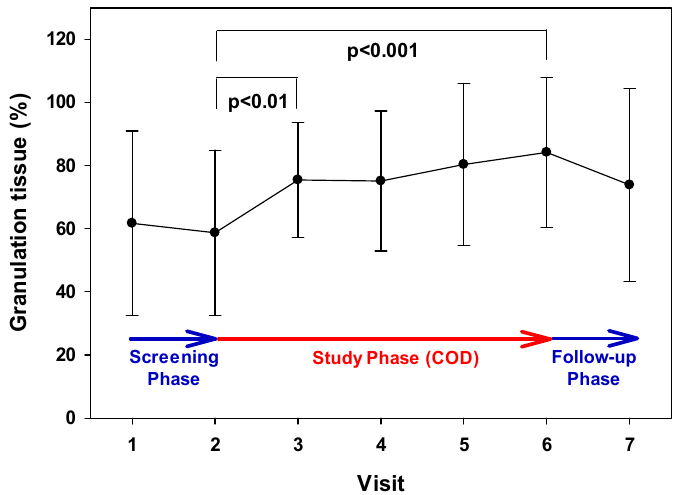
Figure 7. Increase in granulation tissue formation during the Treatment Phase. The mean and SD values of the mean of the granulation scores during each visit are presented. During the Treatment Phase (Visits 2–6), there was a statistically significant increase in the granulation tissue (43.37%; p < 0.001; one-way repeated measures ANOVA). Between Visit 2 and Visit 3, there was a statistically significant increase in the granulation tissue (28.5%; p < 0.01, paired t -test). During the Treatment Phase, there was a reduction in the percent of fibrin tissue (from 26.53% to 13.85%; 47.8% decrease; p = 0.002, one-way repeated measures ANOVA, Figure 8).